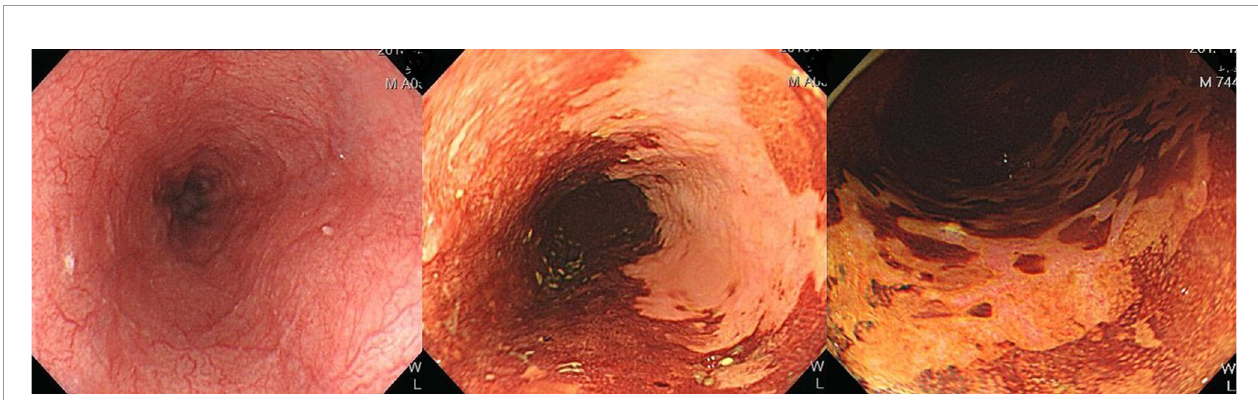
FIGURE 7 | Esophageal high-grade dysplastic lesion. Left : Normal appearance upon white-light endoscopy. Middle : Lugol-voiding unstained mucosa. Right : The color of Lugol-unstained mucosa turns pink in a few